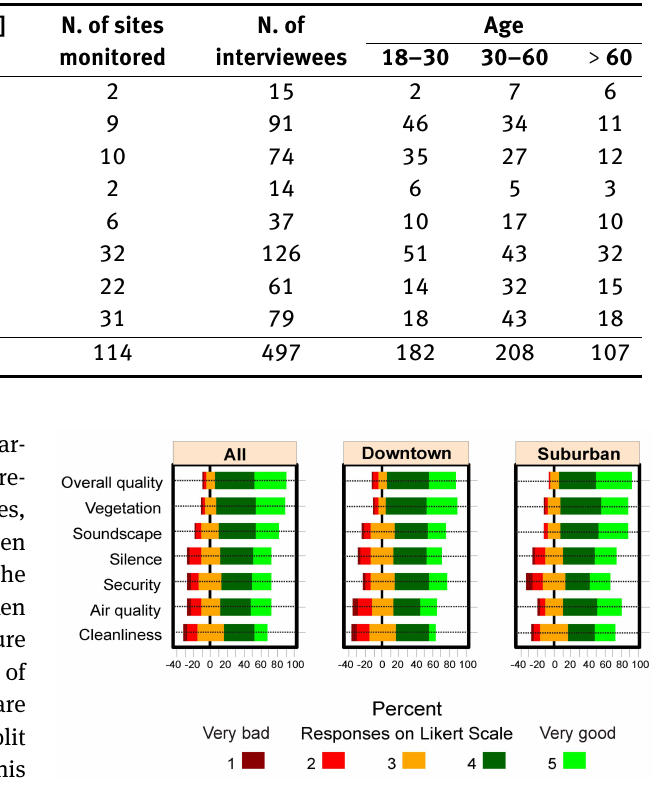
Figure 4: Diverging stacked bar charts of the responses for each park feature.